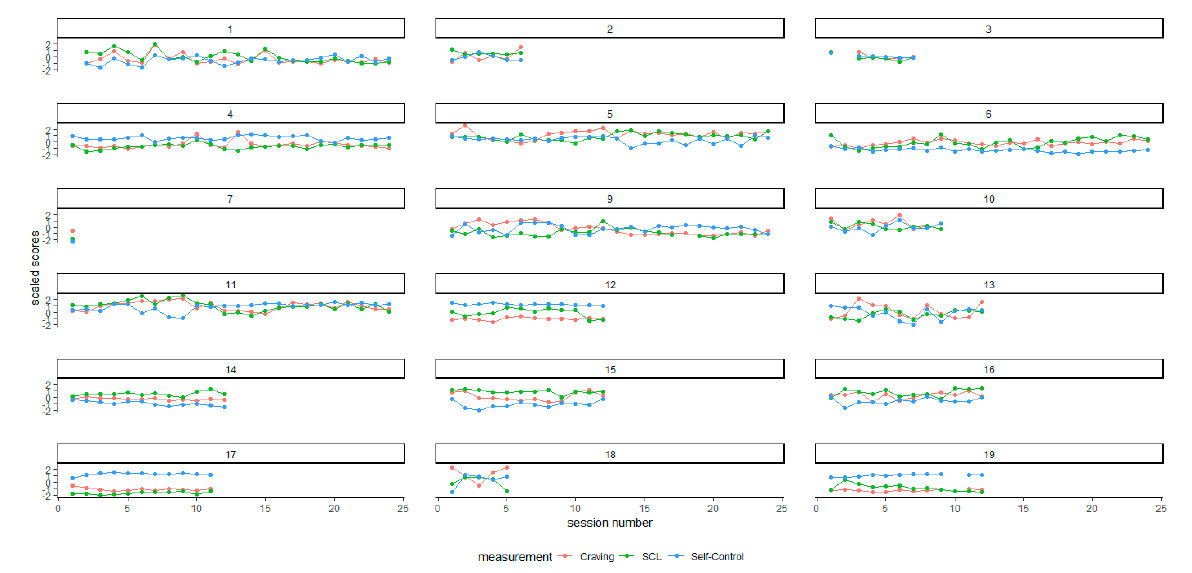
Figure 2. The repeated measures for participants 1–19, standardized scores for comparison (stan- dardized using the mean and standard deviations across occasions) for craving, Hopkins Symptom Check List 5-item version (SCL) and self-control. Participant 8 was removed due to missing data, participant 7 only reported data on one occasion post baseline.